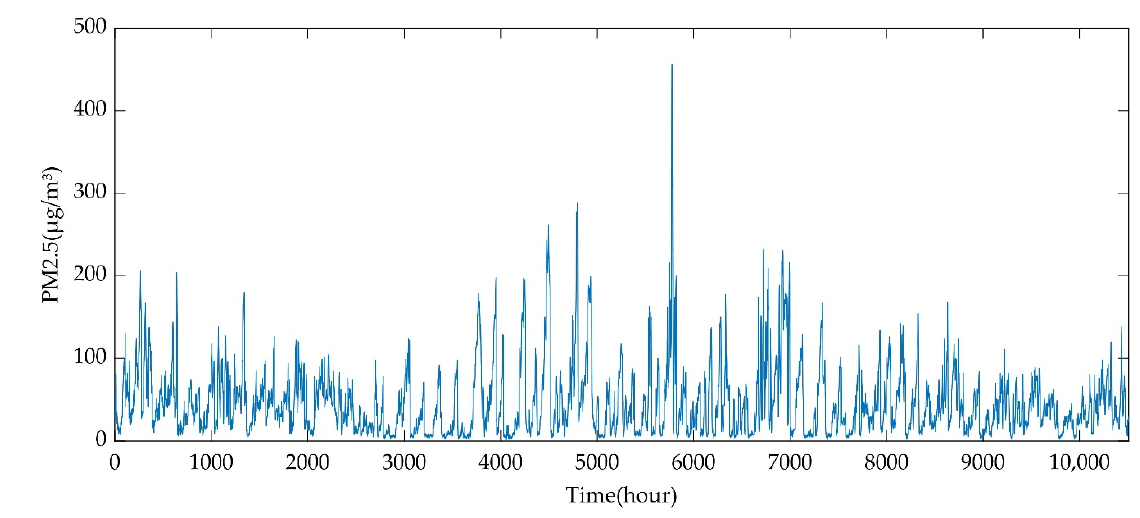
Figure 3. Original PM2.5 concentration time series.